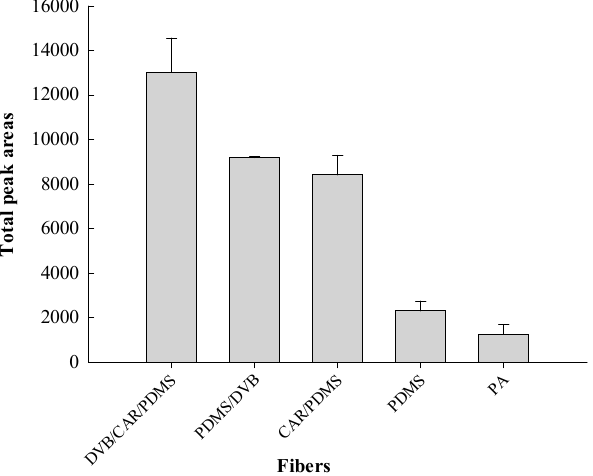
Figure 1. Comparisons of the total peak areas of total volatile compounds detected in the headspace Nongshi No. 1 using di ff erent headspace solid-phase microextraction (HS-SPME) of Nongshi No. 1 using different headspace solid-phase microextraction (HS-SPME) fibers.